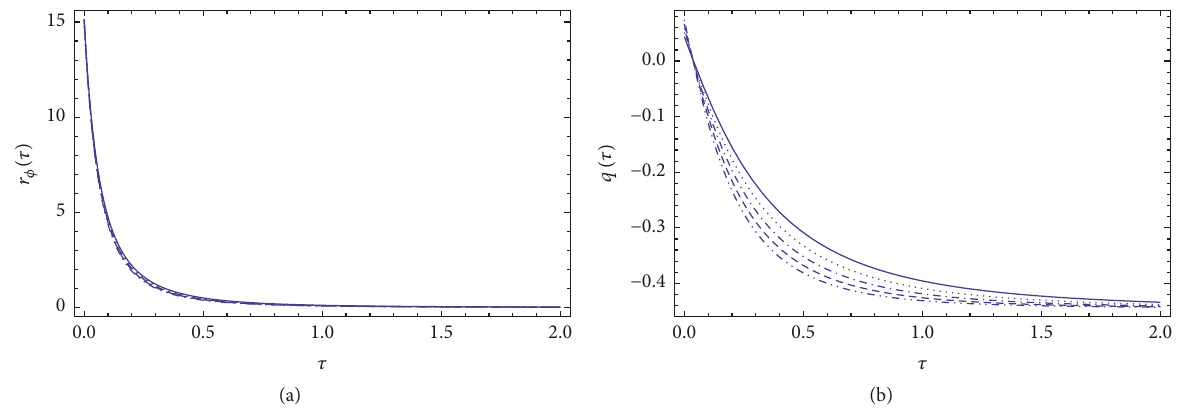
Figure 6: Time variation of the energy density of the scalar field (a) and of the deceleration parameter (b) during the reheating period in the presence of an exponential scalar field potential, for different values 𝛼 𝜙 of the decay width of the scalar field: 𝛼 𝜙 = 1.15 (solid curve), 𝛼 𝜙 = 1.35 (dotted curve), 𝛼 𝜙 = 1.55 (dash dotted curve), 𝛼 𝜙 = 1.75 (dashed curve), and 𝛼 𝜙 = 1.95 (dash double dotted curve), respectively. For 𝑝 we have adopted the value 𝑝 = 5 . The initial conditions used to numerically integrate (102) are 𝜙(0) = 15 , 𝑢(0) = −5.5 , 𝑁 𝜙 (0) = 20 , 𝑟 DM (0) = 0 , and 𝑟 m (0) = 0 ,